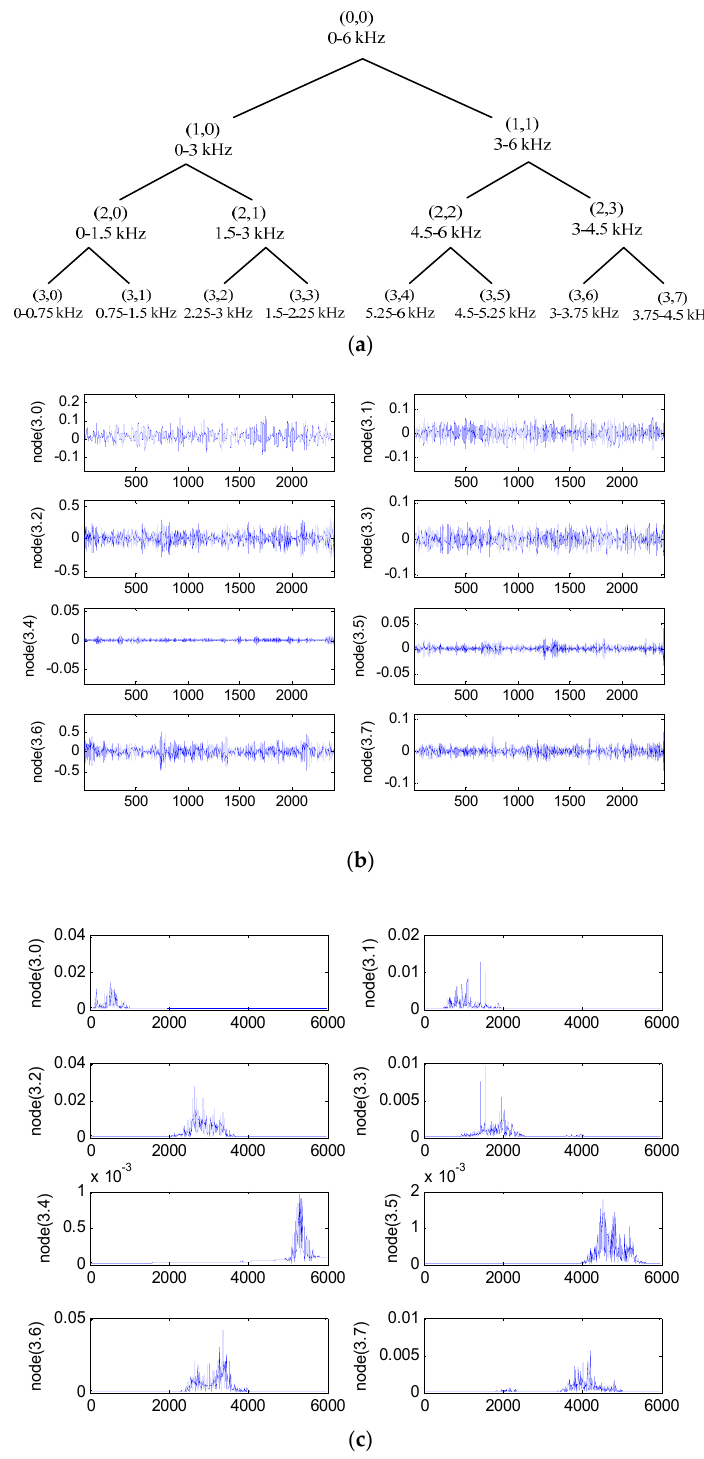
Figure 7. Vibration signal decomposed by WPT with a load of 0 hp and a fault diameter of 0.007 in under a ball fault. ( a ) Three-level wavelet decomposition tree; ( b ) decomposed signals corresponding to each node; ( c ) spectrum diagram of the decomposed vibration signal corresponding to each node.